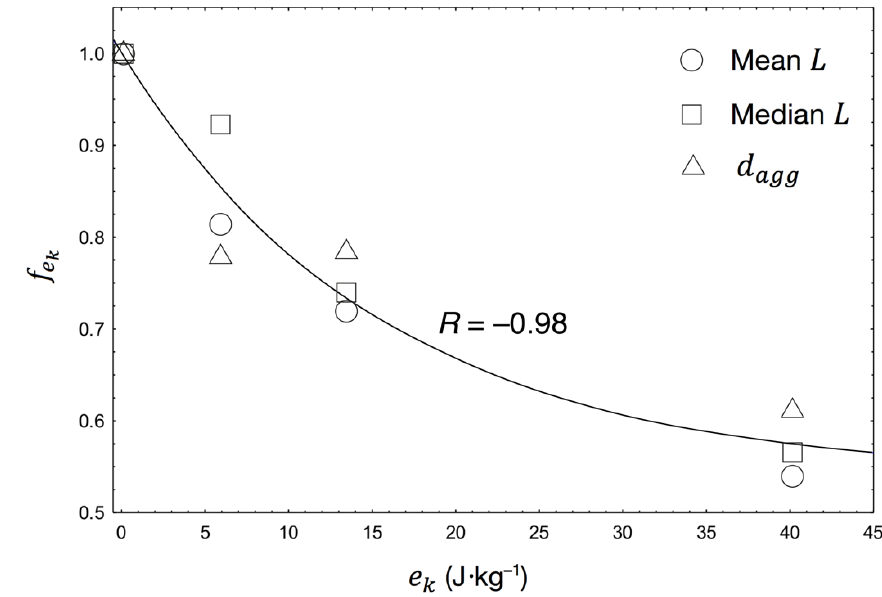
Figure 7. Plot of remaining fraction of initial values ( 𝑓 𝑒 lengths 𝐿 and calculated 𝑑 𝑎𝑔𝑔 values as a function of shaking energy 𝑒 𝑘 . The best fit curve (grey) accounts for 98% of the variance in the data points ( 𝑅 = –0.98).